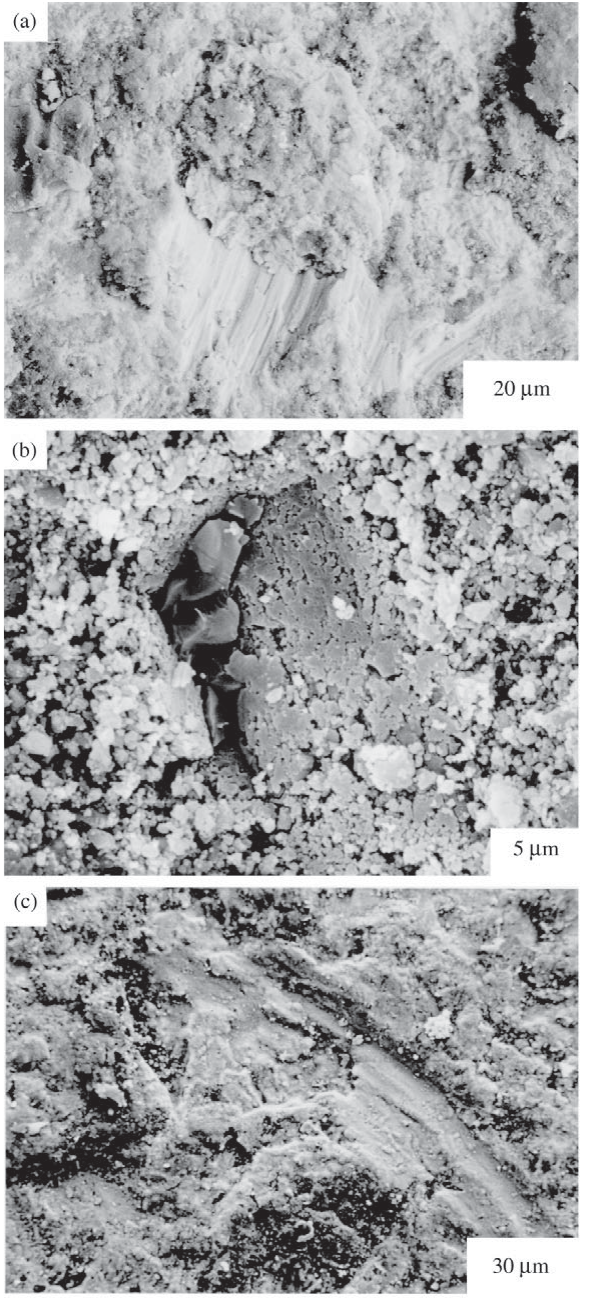
Figure 4. Backscattered SEM images of impact scars in the maxi- mum wastage regions on specimens tested with batch 1 sand at: a) 300 °C, low dust condition; b) 450 °C, high dust condition; c) 500 °C, low dust condition.